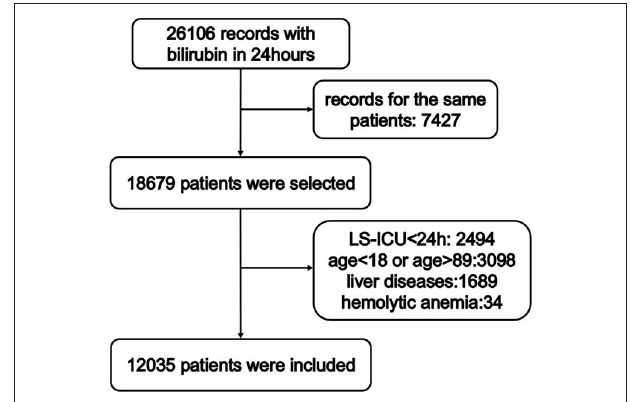
FIGURE 1 | Overview of patients’ selection. LS-ICU, length of stay in ICU.